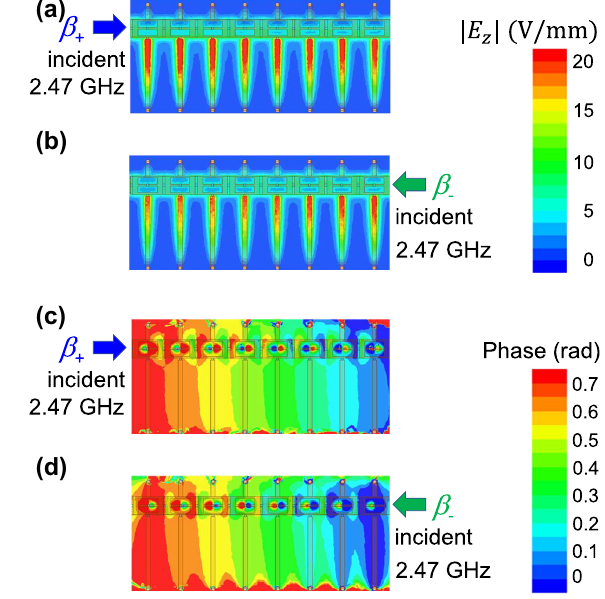
Figure 7: Magnitude and phase distribution of the electric field component E z observed on a plane a half the substrate thickness above the ground plane at 1.65 GHz. (a), (b) Magnitude. (c), (d) Phase distribution. Signal incidence